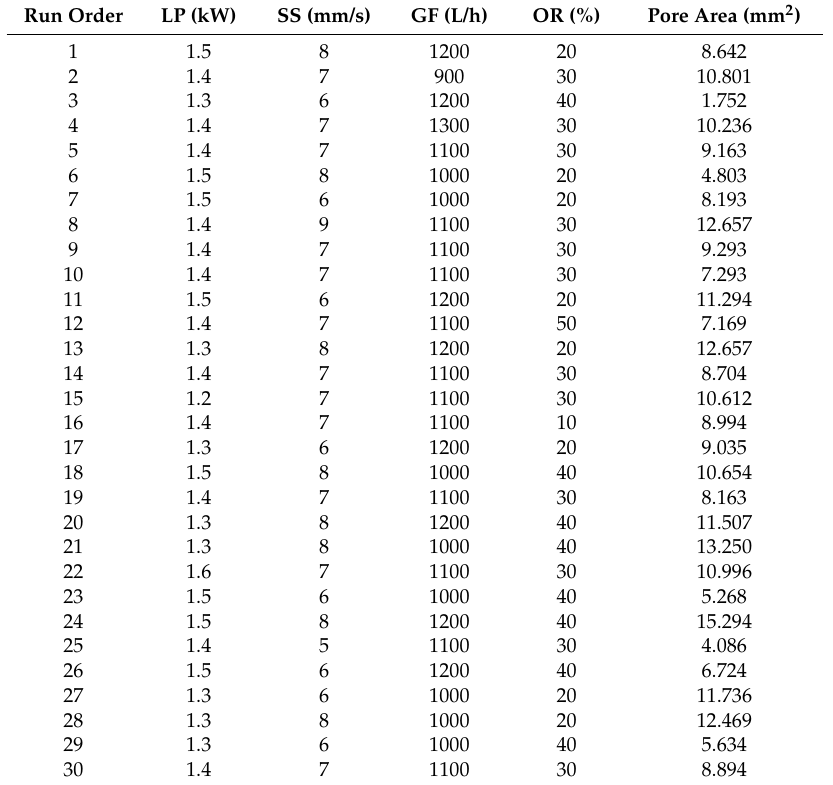
Table A1. Central composition design and results.